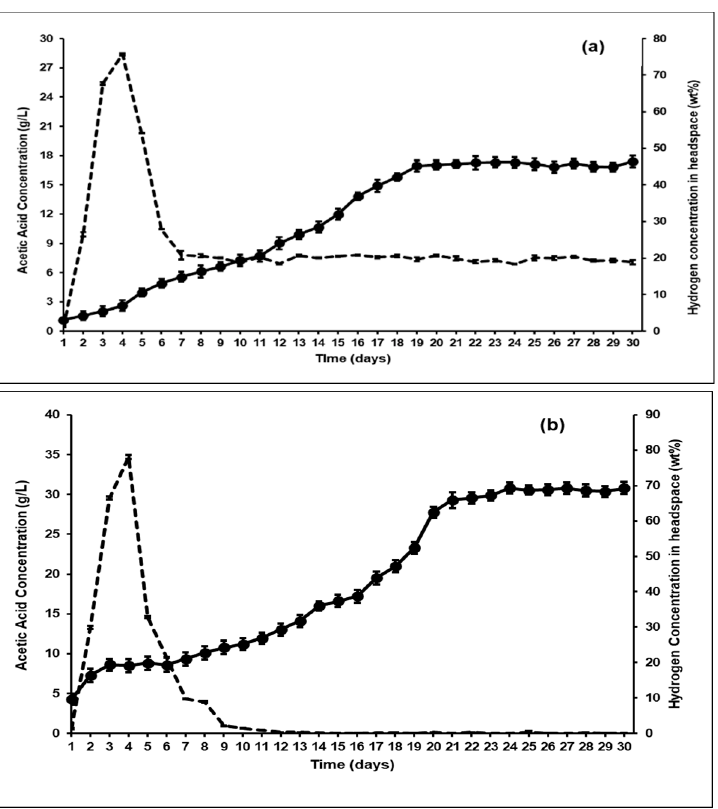
Figure 6. Hydrogen concentration in headspace(wt%) versus acetic acid concentration (g/L) in semicontinuous bioreactors bioaugmented with ( a ) Acetitomaculum ruminis and ( b ) Acetobacterium woodii ( --- Hydrogen concentration (wt%); Acetic acid concentration (g/L)).